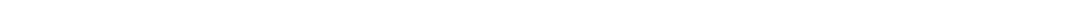
n = 12 and 21 independent